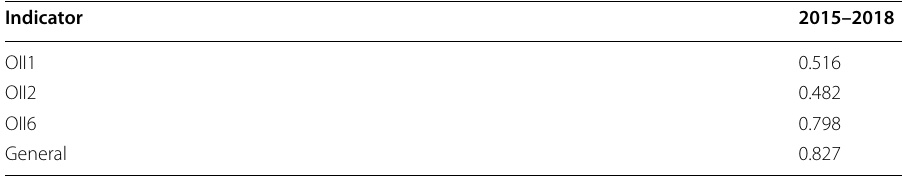
Table 7 Stone–Geisser test Q 2